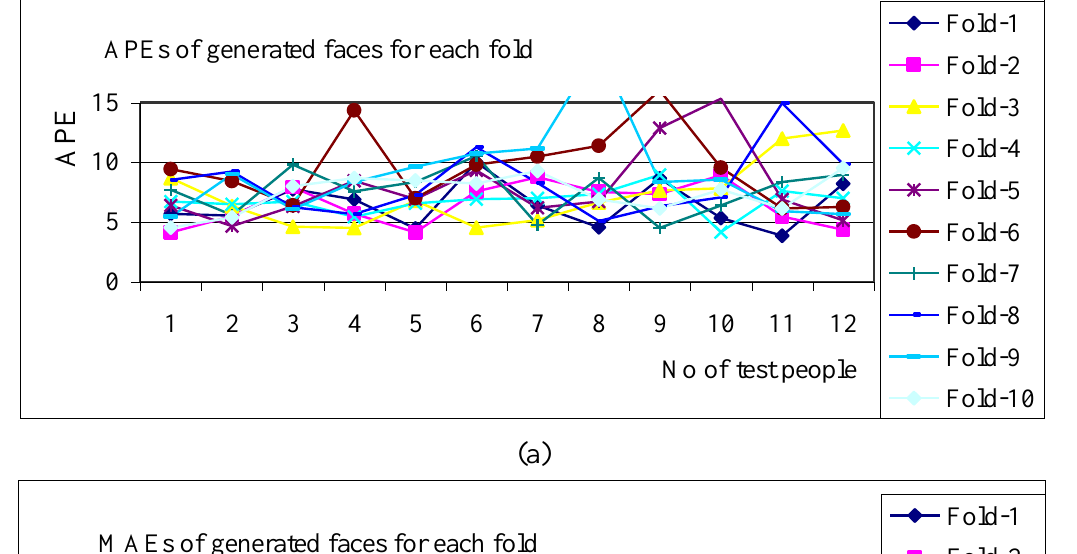
Figure 14. Results for APEs, MAEs and MAPEs for each fold. (a) APEs for generated faces for each fold; (b) MAEs for generated faces for each fold; (c) MAPEs for generated faces for each